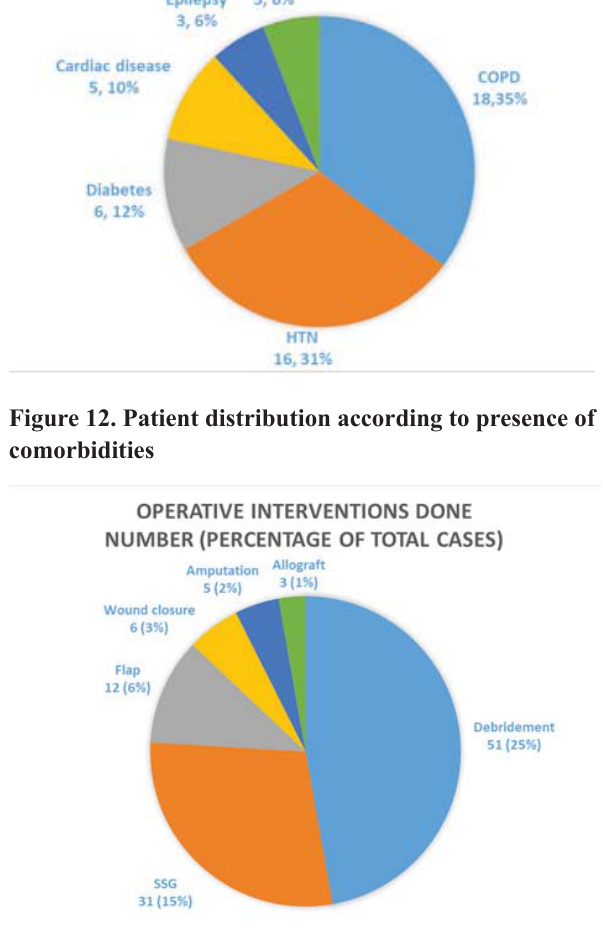
Figure 10. Seasonal variation of burn cases along with mortality